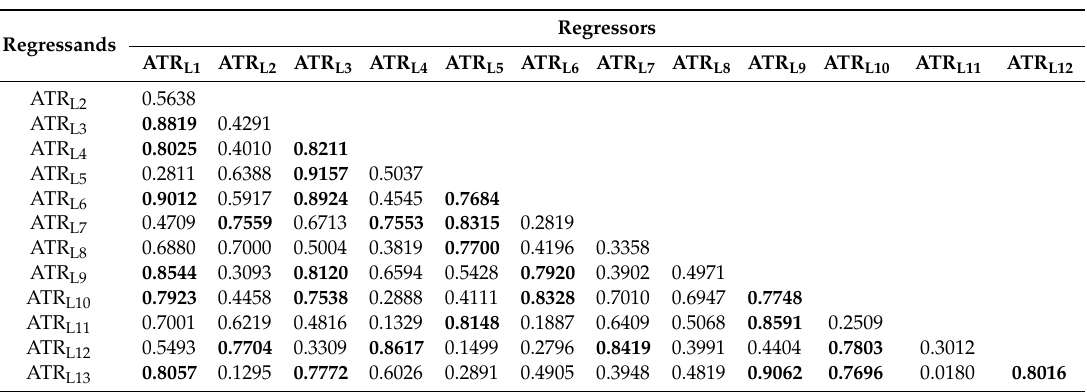
Table 5. Correlation matrix for type III territories.